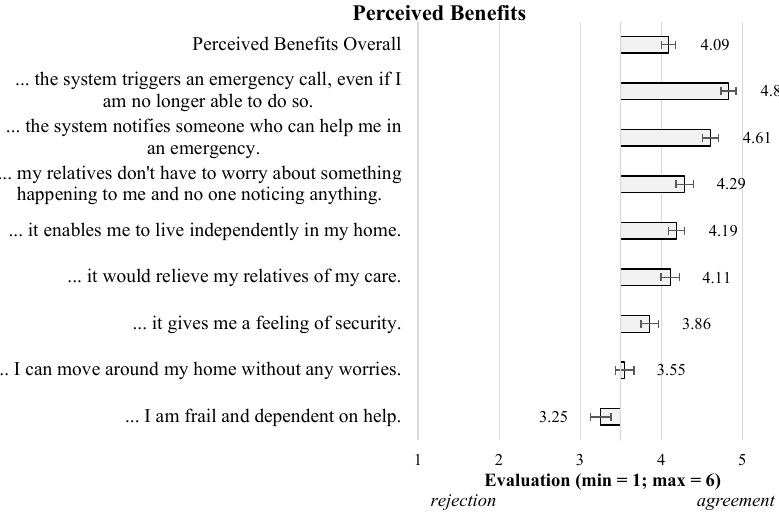
Figure 3. Perceived benefits of using video-based AAL technology (n = 161).